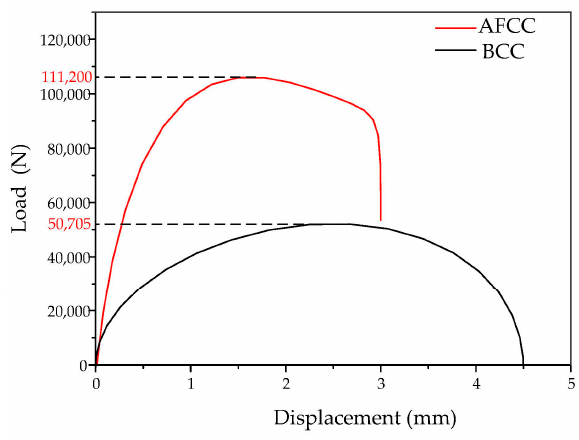
Figure 6. Load–displacement curves of AFCC and BCC lattice structures.